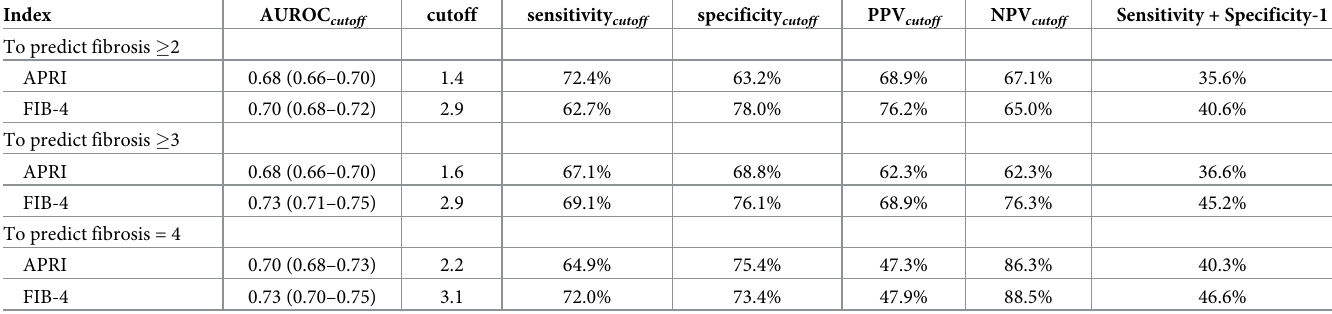
Table 2. Diagnostic accuracies of APRI and FIB-4 for predicting liver fibrosis (all patients, N =